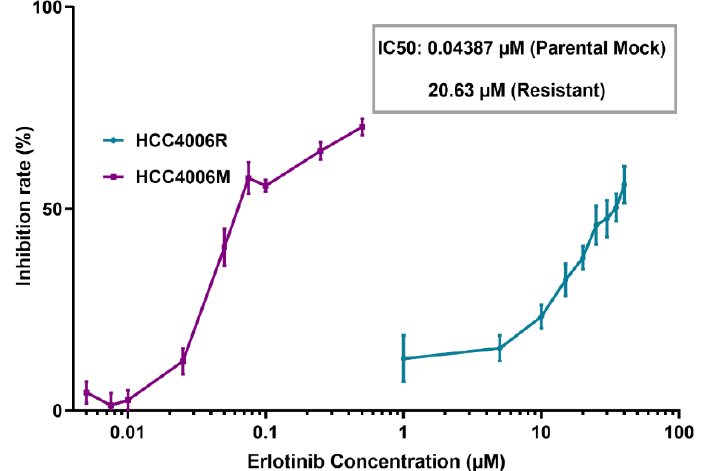
Figure 2. MTS assay of HCC4006 and HCC4006R cell lines. The drug resistance (HCC4006R) cell line was established by 10 cycles of drug treatment. Compared to drug-sensitive HCC4006M cells, a three orders of magnitude increase in the concentration of erlotinib is required to reduce the via- bility of HCC4006R cell line to 50%.